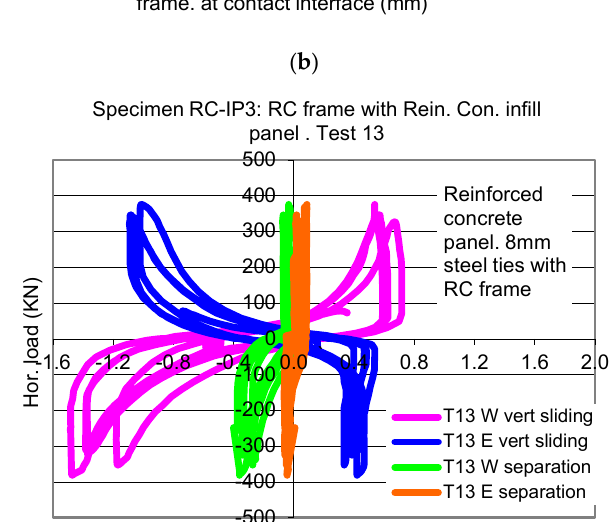
Sliding and separation displ. between UC infill panel and frame. at contact interface (mm)